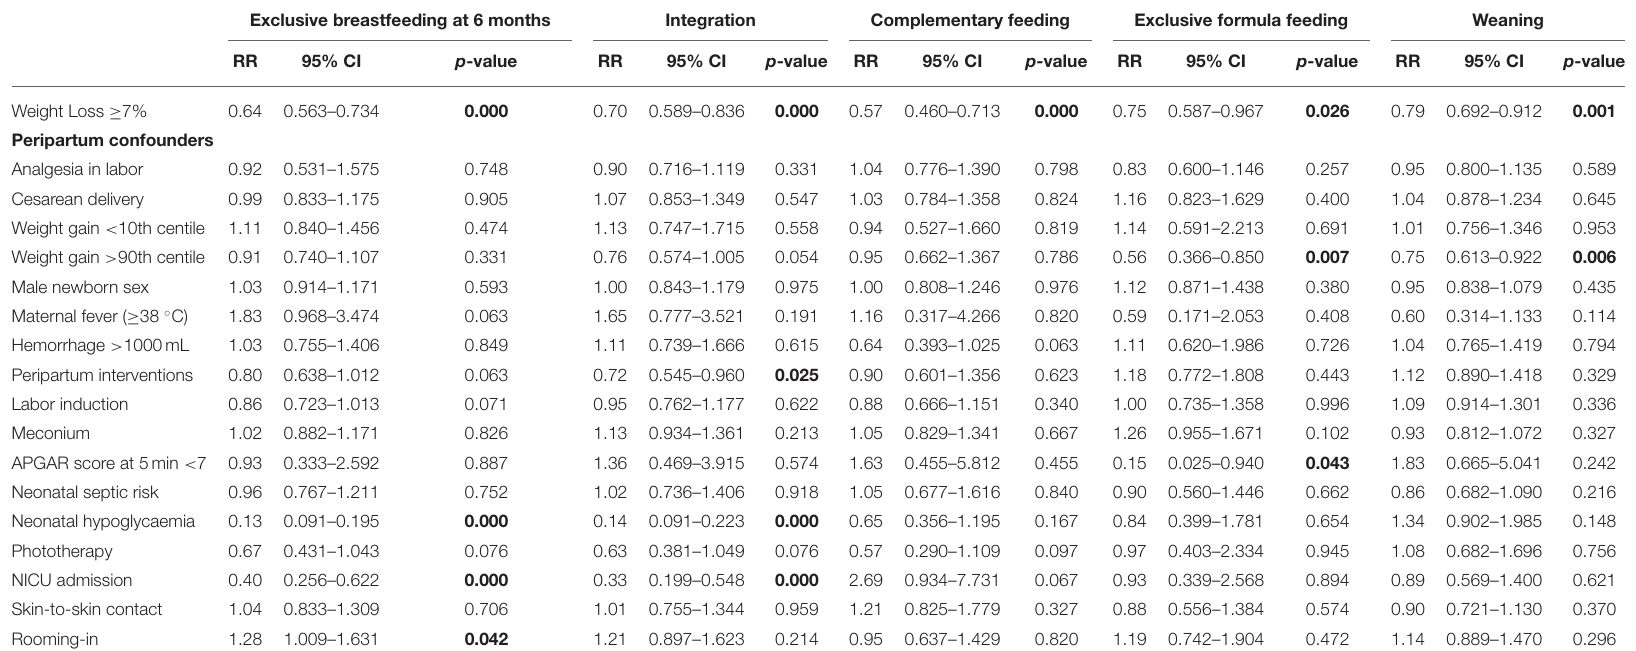
TABLE 6 | Table of statistical